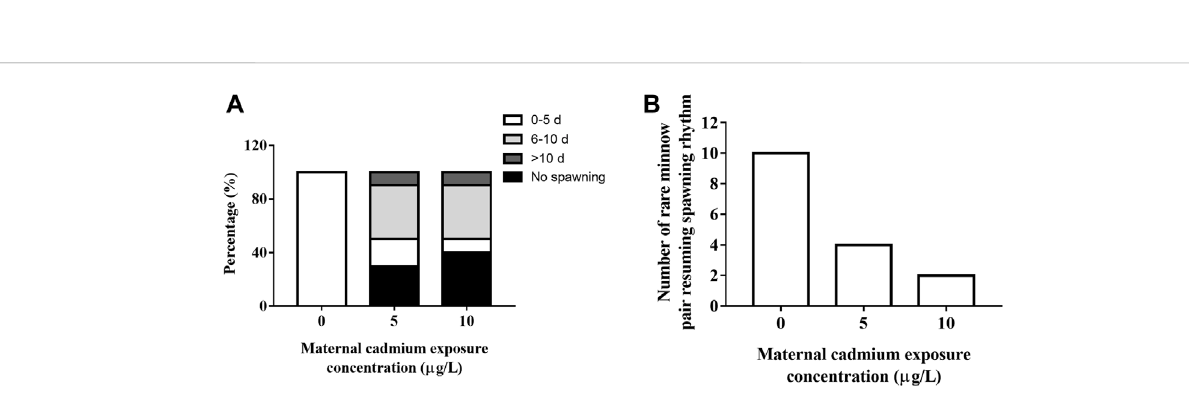
During the reproductive period, paired rare minnow resumed spawning. Compared with the control group, the mean time for fi rst spawning in the 28 days Cd exposure groups signi fi cantly increased (Table 2, p < 0.05). According to Su et al. ’ s (2020) criteria for resuming spawning rhythm, all paired rare minnows in the control group spawned within 5 days. However, only four and two pairs of